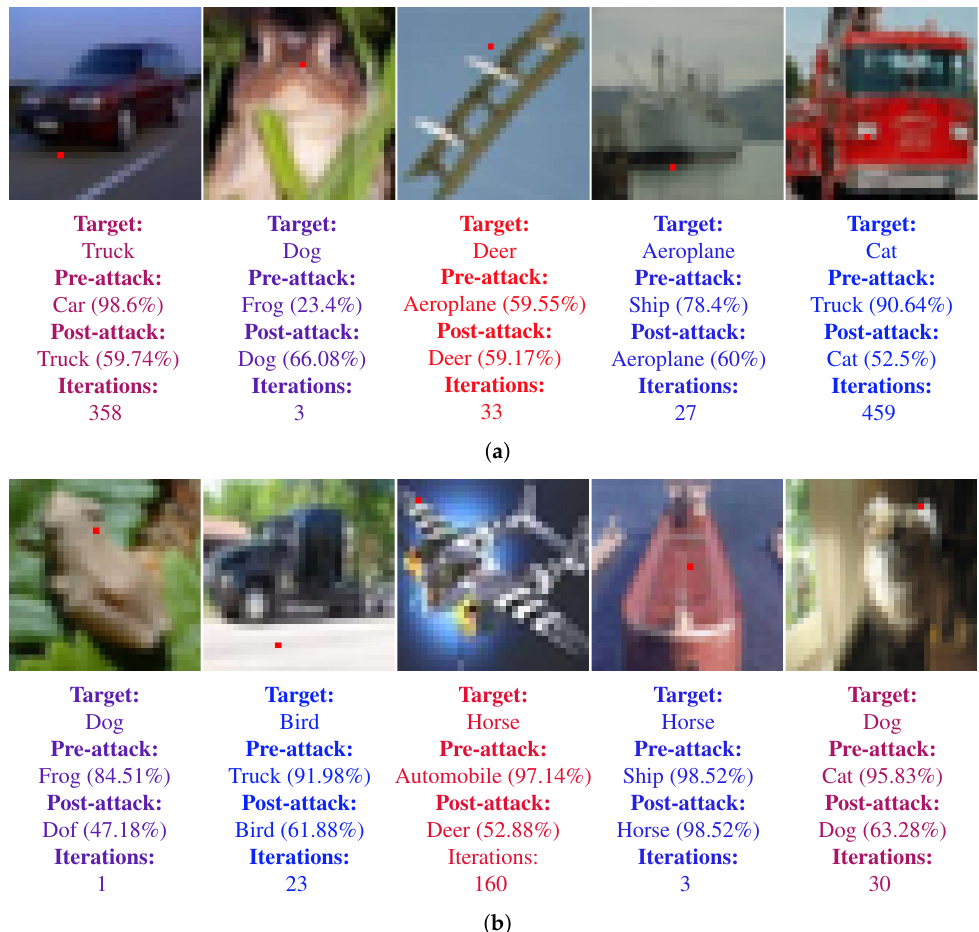
Figure 10. Samples of single pixel successful targeted attacks on both LeNet-5 and ResNet architec- tures. Perturbed pixel is marked as red. The pre-attack, post-attack predictions and confidences along with the number of iteration required to fool the CNN are also shown below the images. ( a ) Samples for LeNet-5. ( b ) Samples for